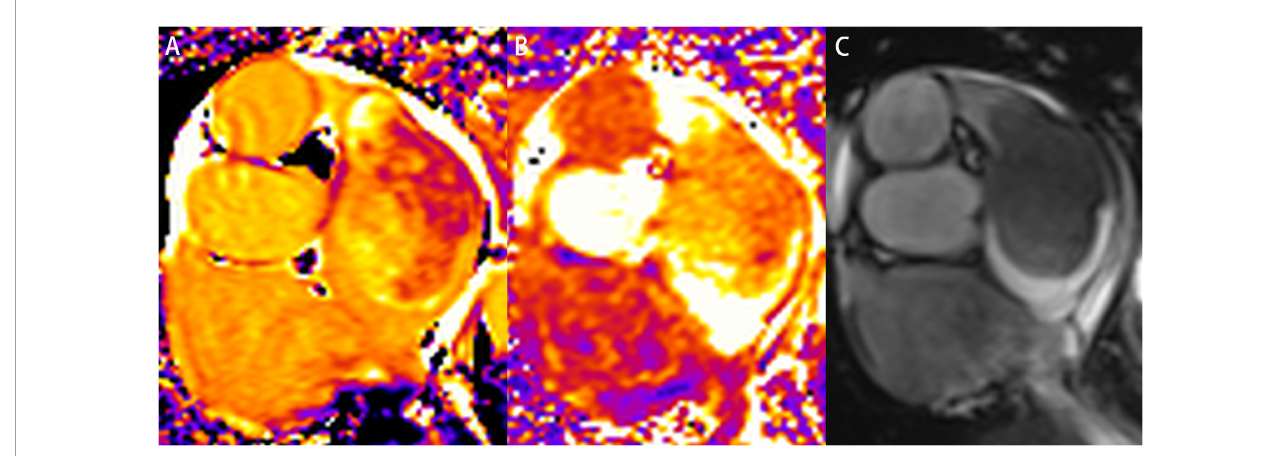
FIGURE3 Characterization of the left atrial mass on cardiovascular magnetic resonance imaging. A slice of a short-axis view of left atrium was acquired on native T1 mapping (A) , T2 mapping (B) , and cine imaging (C) , respectively. The mass was heterogeneous on native T1 mapping and T2 mapping. The native T1 value ranged from 1,661 to 2,109 ms. The T2 value was also significantly elevated.